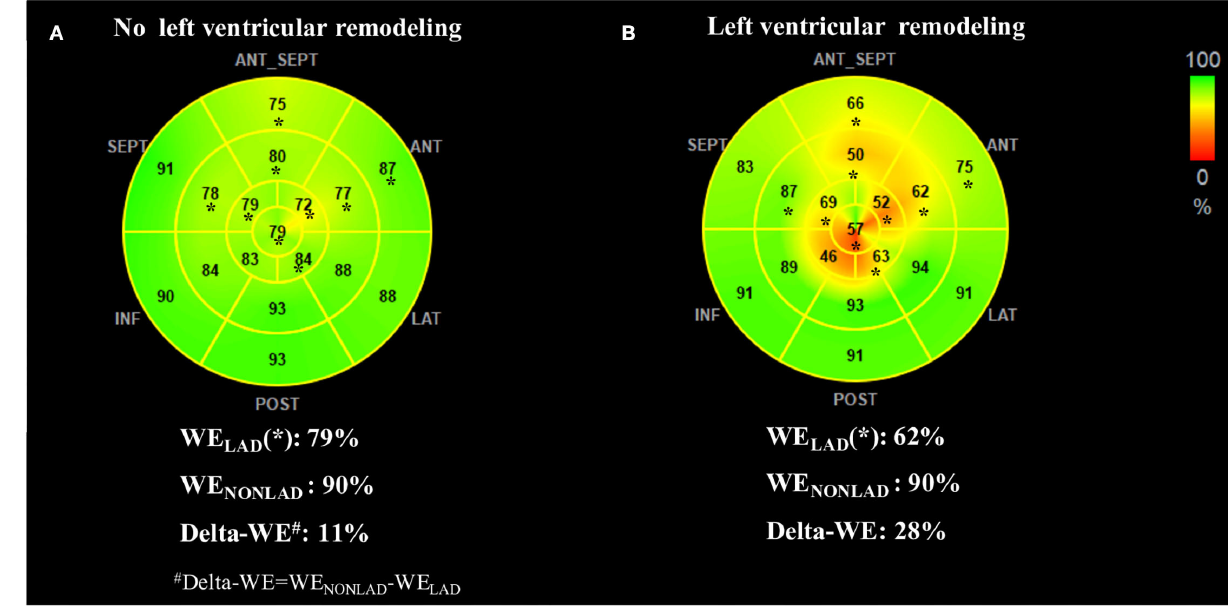
FIGURE 3 | Representative WE bull’s-eye plots of patients without (A) and with (B) early left ventricular remodeling. Asterisks indicate segments assigned to the left anterior descending coronary artery (LAD) territory. The no-remodeling patient showed relatively homogeneous regional WE (presented in green) between LAD and non-LAD territory. In contrast, the remodeling patient exhibited significantly reduced WE in LAD territory (presented in yellow and orange). The index of delta-WE (calculated as WE NONLAD – WE LAD ) was much greater in the remodeling patient than the no-remodeling (28 vs. 11%), indicating a more inhomogeneous distribution of regional WE. LAD, left anterior descending artery coronary artery; LV, left ventricular; WE, work efficiency; WE LAD , average of segmental WE in LAD territory; WE NONLAD , average of segmental WE in non-LAD